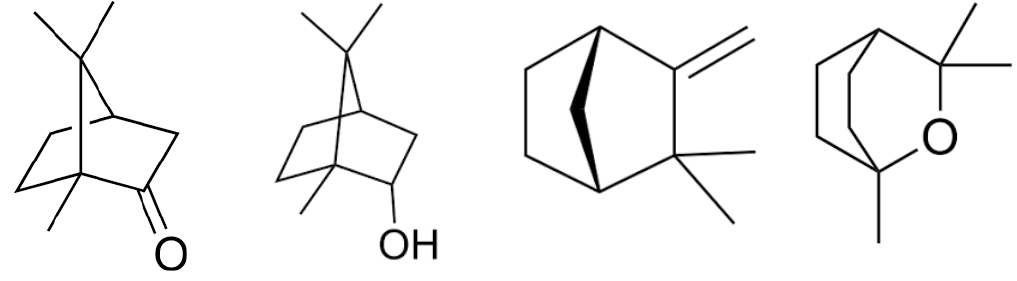
Figure 1. Major constituents in MDEO.